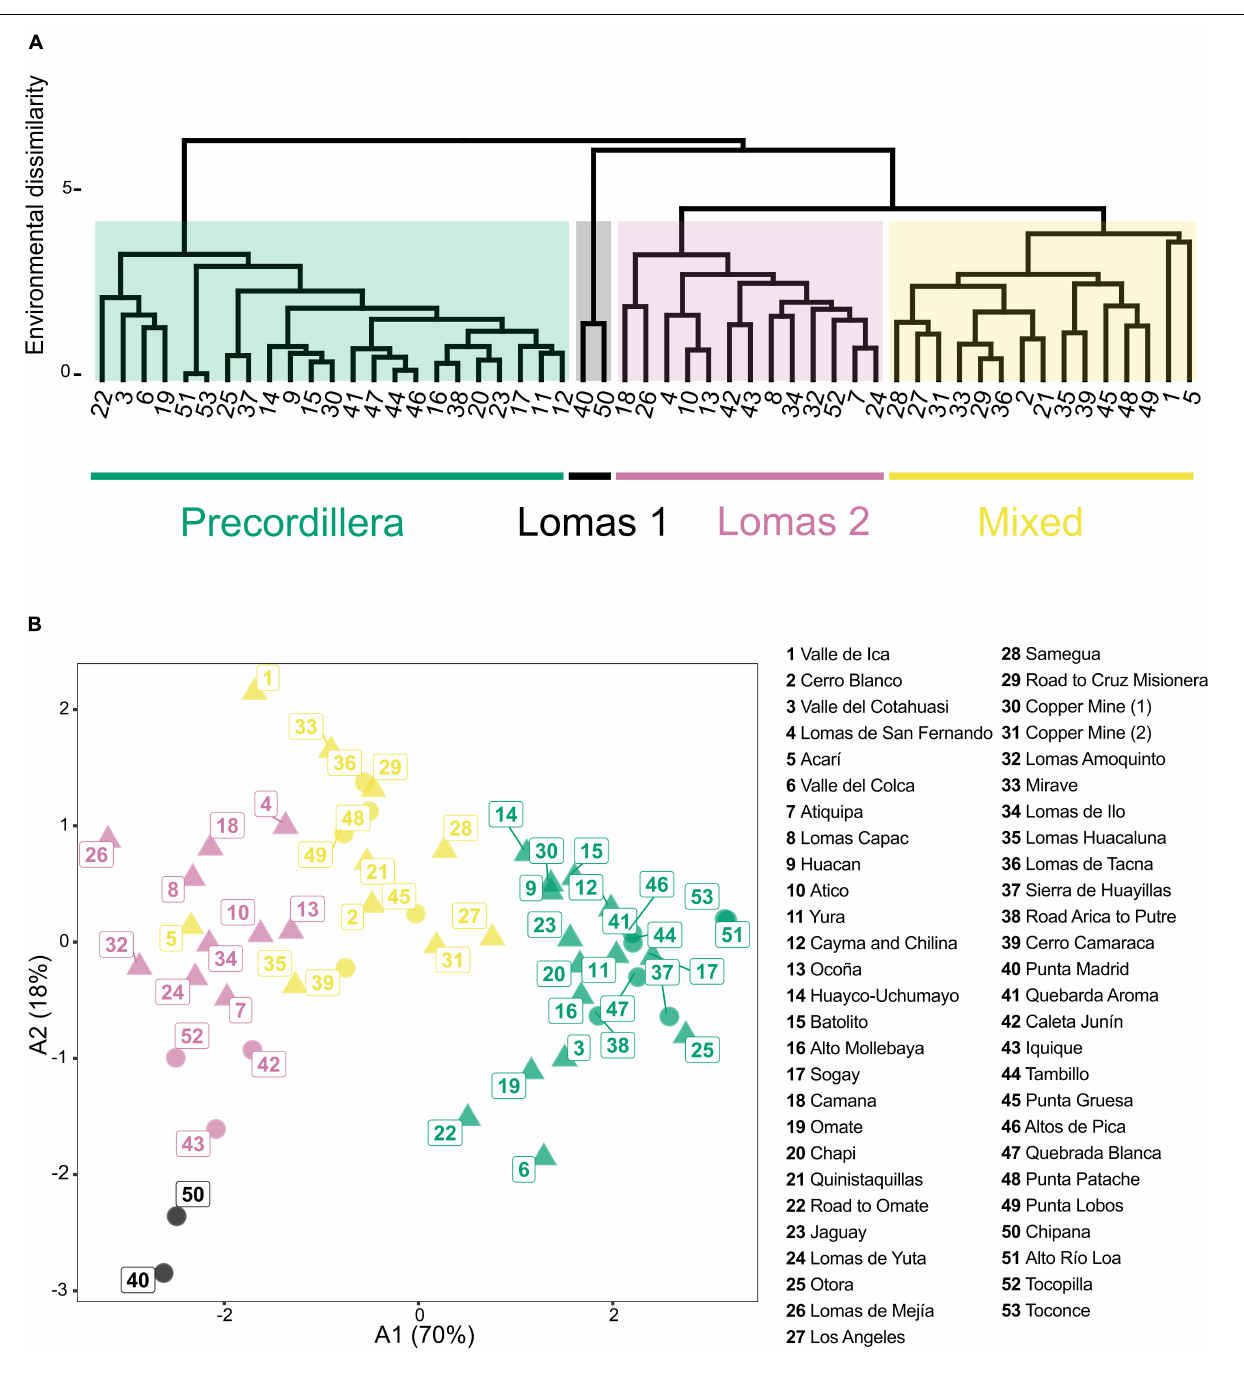
FIGURE 5 | (A) Dendrogram based on cluster analysis of environmental data. between Peruvian and Chilean desert locations. Pairwise distances between locations were calculated using Euclidean distance. Clustering is based on UPGMA. Numbers refer to the numbers in the Overview map ( Figure 1 ). (B) Principal component analysis (PCA) of Peruvian (circle) and Chilean (triangle) desert locations based on environmental data. X- and y-axis correspond to the first two axes (A1 and A2) from PCA of environmental data. Values of A1 and A2 indicate proportion of total variance explained by each axis. Colors of locations indicate cluster identities retrieved from cluster analysis ( Figure 6A ). Ordination retrieves lomas clusters separated from the precordillera cluster with the mixed cluster in